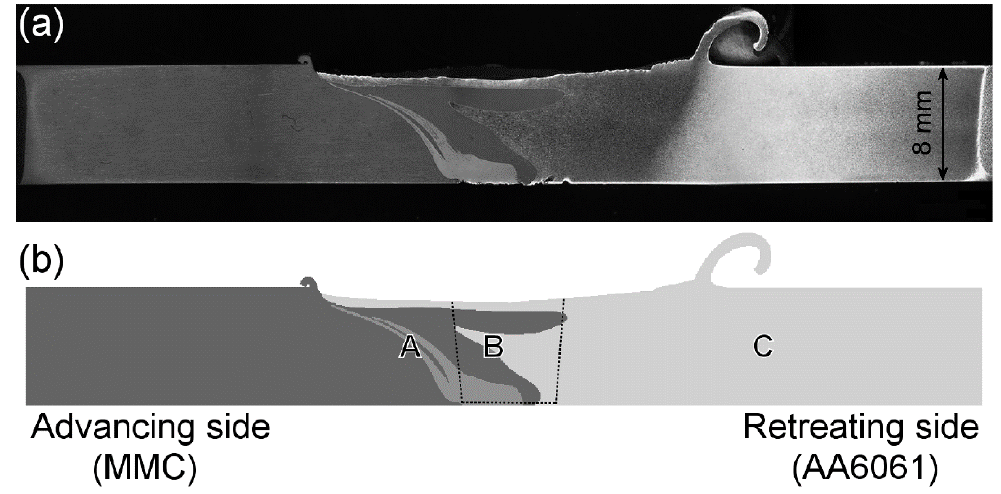
Figure 3. Optical micrograph ( a ) and schematic illustration ( b ) of the cross-section of the friction stir welded AA6061/MMC plate. Dark-gray and light-gray regions correspond to the MMC and the AA6061 alloy, respectively. Intermediate shading corresponds to the area which appears to be one broad band close to the plate bottom and which splits into two narrower individual bands on the advancing side. Letters A to C in ( b ) indicate the inspected regions, while dashed lines indicate the approximate location of the pin during FSW.